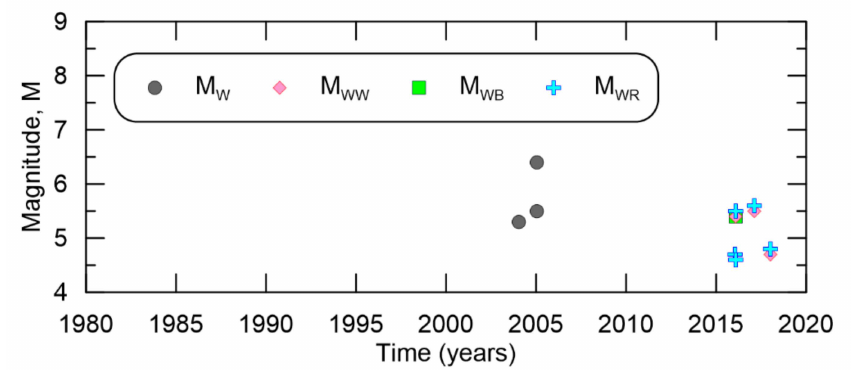
Figure 10. Moment magnitude types from NEIC and timeframes when they are valid in the South Korean catalog.